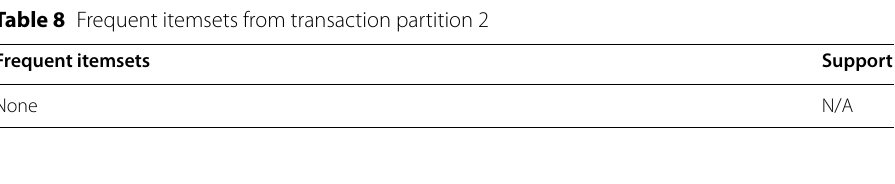
Table 9 Frequent itemset final